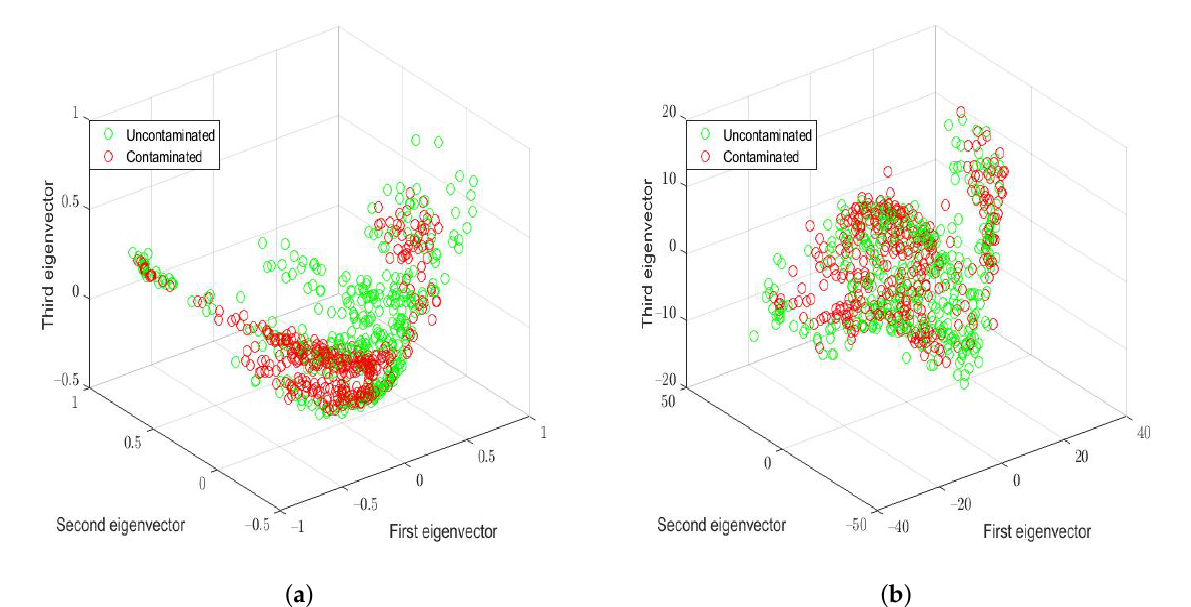
Figure 5. Data distribution on the 3 most significant eigenvectors. ( a ) Complex nature dataset. ( b ) Amplitude only